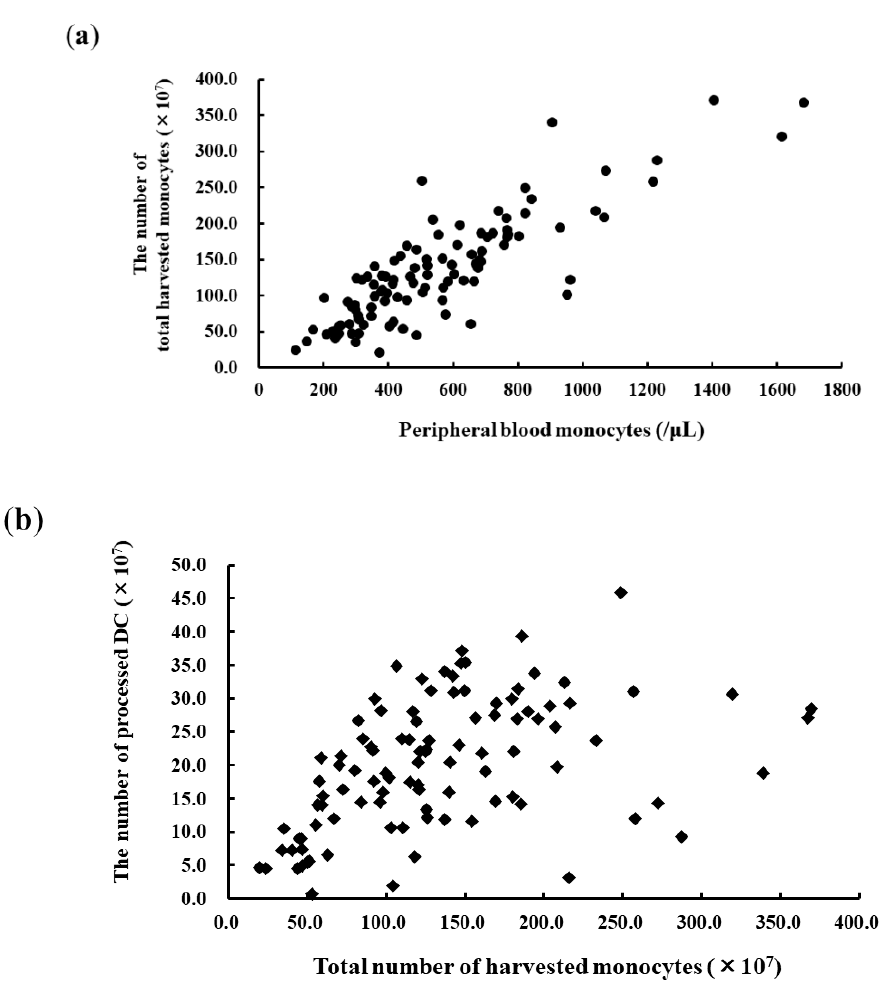
Figure 1. The yield of dendritic cells (DCs) depending on the number of apheresed monocytes. ( a ) Correlation between peripheral blood monocyte counts and the number of monocytes harvested by apheresis ( r = 0.828, p < 0.0001, n = 108). ( b ) The number of DCs that could be harvested was dependent on the number of apheresed monocytes ( r = 0.435, p < 0.0001, n = 108). Mean number of DCs, 20.2 × 10 7 ; DC / apheresed monocyte-ratio, 17.0% ± 7.7%.